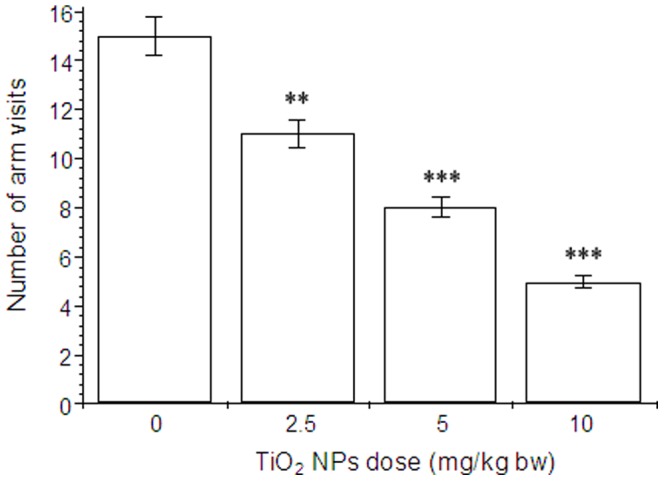
Effects of TiO2 NPs on locomotor activity in mice in the Y-maze after nasal administration of TiO2 NPs for 90 consecutive days.Bars marked with an asterisk, double asterisks or three asterisks means it is significantly different from the control (unexposed mice) at the 5, 1, and 0.1% confidence level, respectively. Values represent means ± D (N = 10).